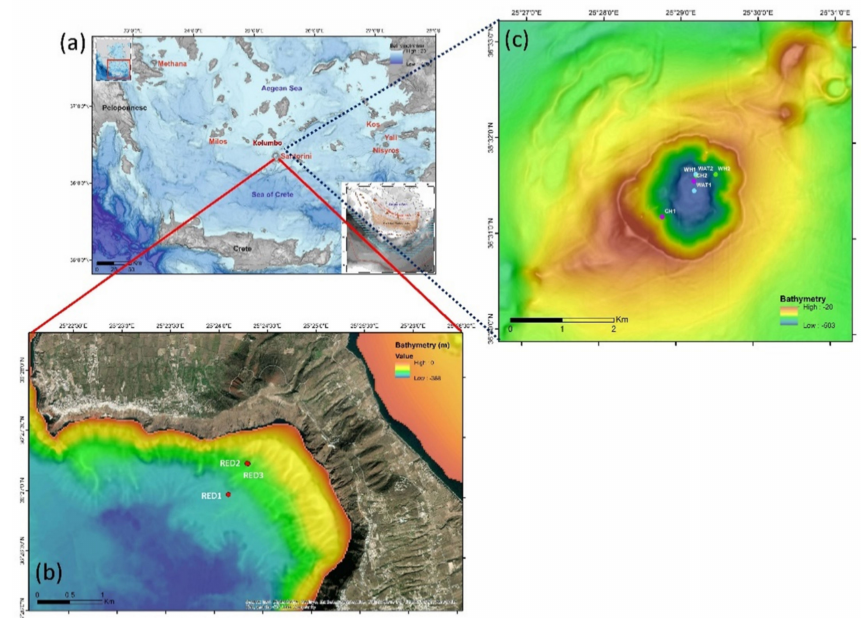
Figure 1. ( a ) Map showing the positions of the samples that were used as sources of metagenomic data; ( b ) Details of samples position in Santorini caldera (red dots); ( c ) Details of samples position in Kolumbo volcano.